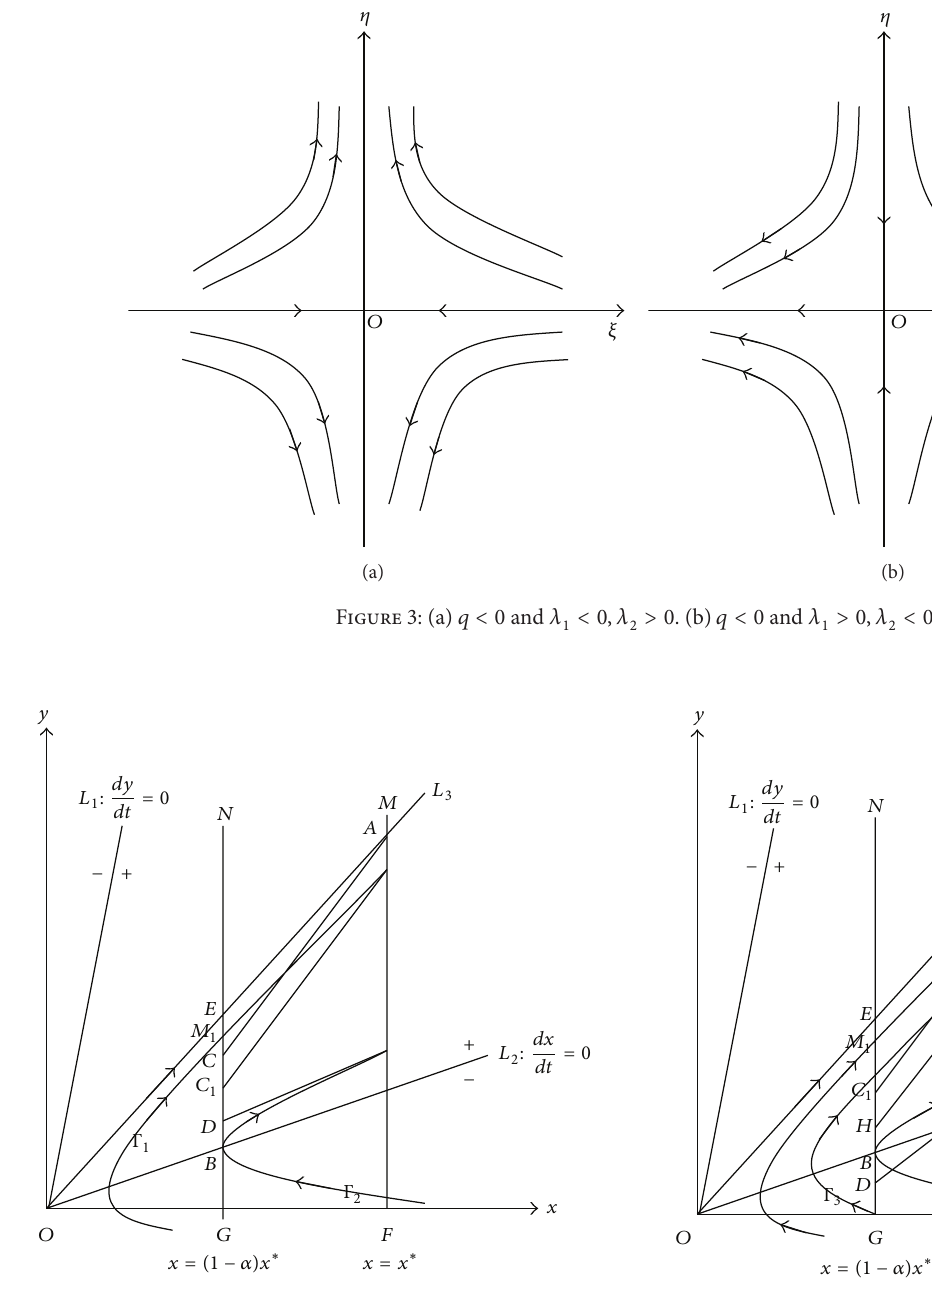
Figure 4: The existence of order-1 periodic solution of system (1) in the domain Δ𝑂𝐹𝐴 when 𝐷 𝑦 > 𝐵 𝑦 .